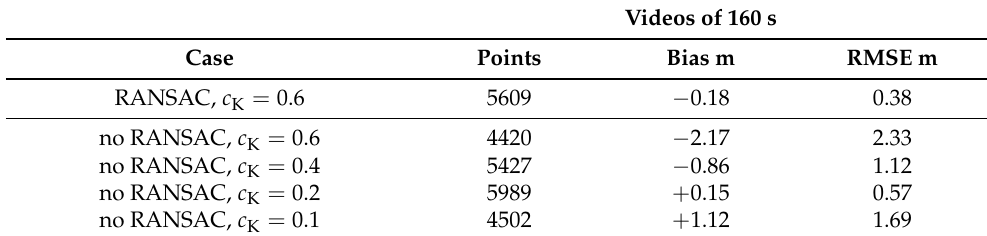
Table 3. Summary results for the bathymetry using RANSAC with e B = 0.075 (reference case) and without RANSAC with e B = 0.15 and for different values of c K